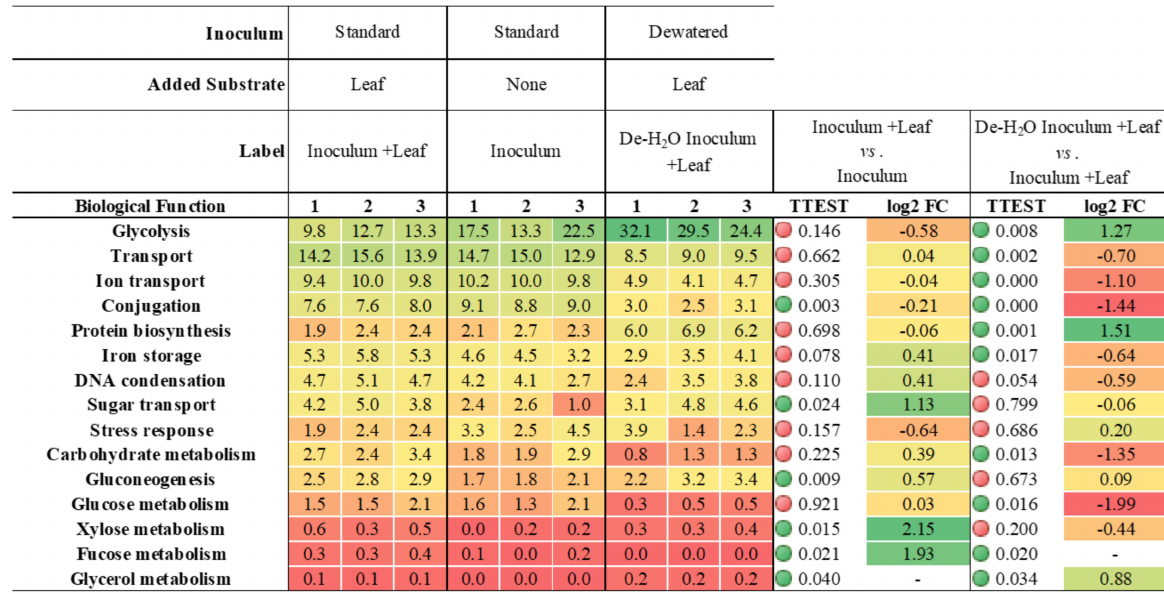
Table 1. Expression of microbial metaproteins related to biological functions (UniProtBB keyword) in In vitro tests incubated with microbiomes derived from giant panda fecal samples (see Figure 1 for the experimental setup; complete list in Table S2A). The heat map, red (low) to green (high), indicates increasing relative abundance or log2 fold changes (log2FC). Red or green circles in TTEST indicate statistical significance ( p <